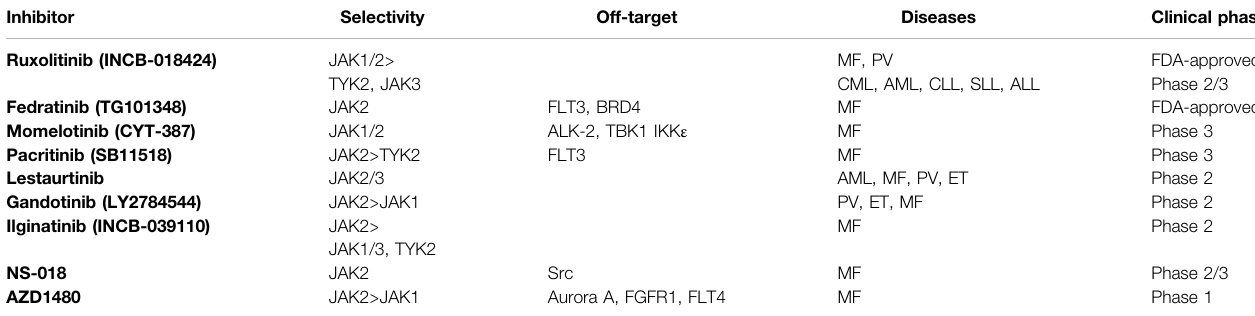
TABLE 4 | Clinical studies of type-I JAK2 inhibitors in hematological malignancies and their speci fi cities. Myelo fi brosis (MF), polycythemia vera (PV), essential thrombocythemia (ET), chronic myeloid leukemia (CML), acute myeloid leukemia (AML), chronic lymphocytic leukemia (CLL), small lymphocytic leukemia (SLL), acute lymphoblastic leukemia (ALL). Adapted from Raivola et al. (2021)(Raivola et al., 2021) and Vainchenker et al. (2018)(Vainchenker et al., 2018).